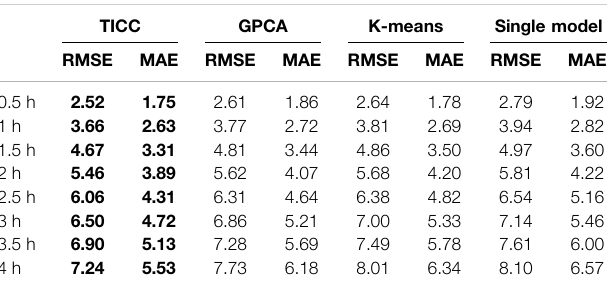
TABLE 2 | The prediction results of different regime division methods (%). The minimum of the RMSE and MAE of different prediction time is in bold. TICC GPCA K-means Single model RMSE MAE RMSE MAE RMSE MAE RMSE